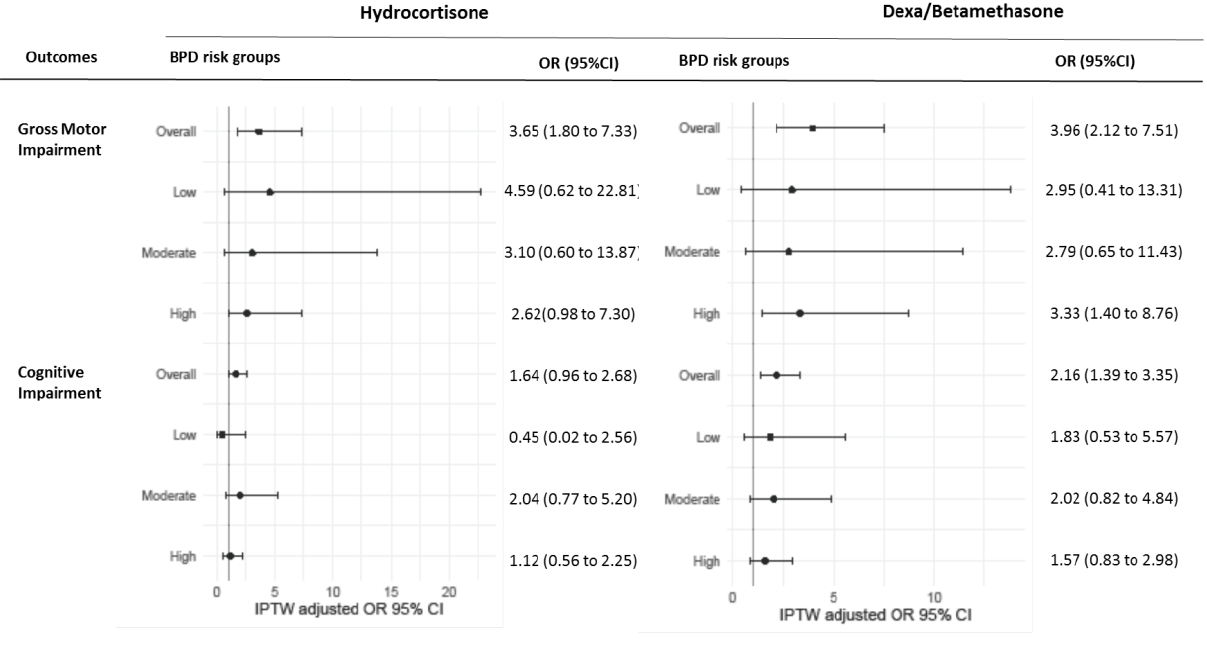
Figure 3. Association of PNS treatment with two-year neurodevelopmental outcome in patients treated with hydrocortisone and dexa/betamethasone after IPTW adjustment. Abbreviations: IPTW, inverse probability of treatment weighting; OR, odds-ratio; CI, confidence interval.